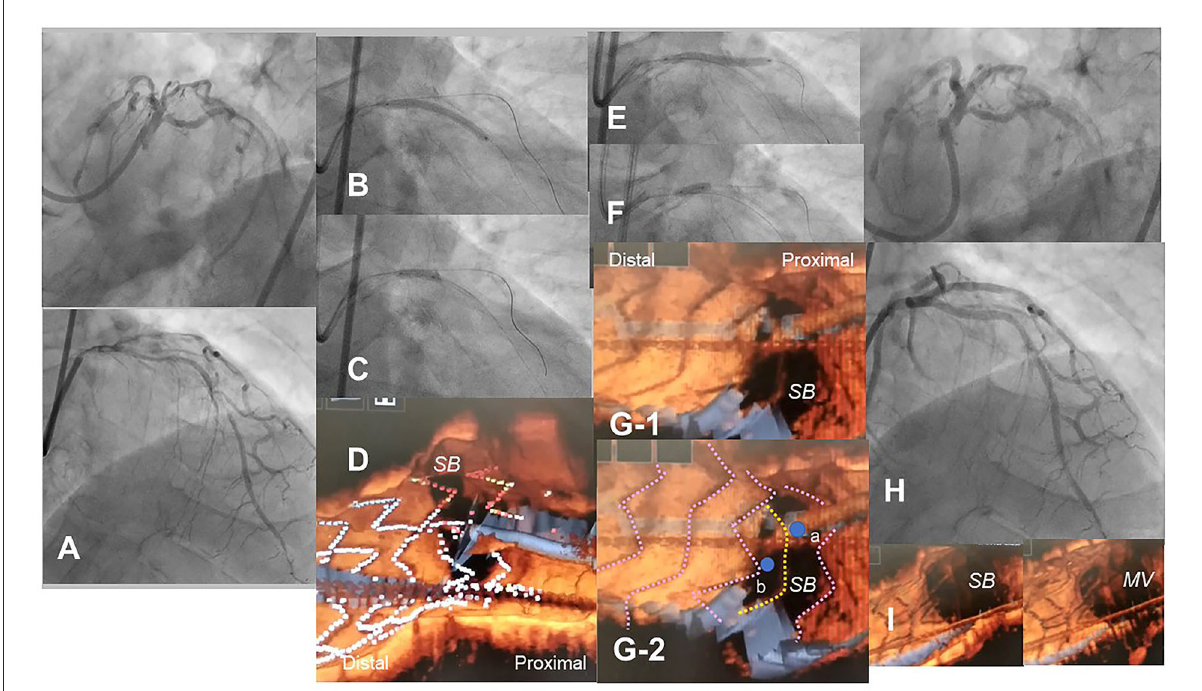
FIGURE8 Optical coherence tomography (OCT)-guided culotte stenting after rotational atherectomy in the calcified bifurcation lesion. A 72-year-old man with Medina 0-1-1 calcified lesion in left anterior descending artery (LAD)-diagonal bifurcation (A) was treated with culotte stenting after rotational atherectomy in both branches (Supplementary Movie 11). Rotational atherectomy using 1.75mm and 2.15mm burrs was performed in both LAD and diagonal branch, and OCT shows adequate ablation. A Ultimaster 3.0/33mm stent was implanted from proximal LAD to diagonal branch (B) followed by proximal optimization with a 3.75mm balloon (C) . 3D OCT showed the guidewire recrossed in the distal cell which occupied most largely in the diagonal branch ostium in the Link-free type that some proximal hoops of the far-distal cells with link-connection remained at the carina (D) . After the dilation of diagonal branch ostium, an Ultimaster 3.0/33mm stent was deployed in the LAD (E) followed by proximal optimization with a 3.75mm balloon (F) . The guidewire seemed to recross in the middle part of the jailing cells ( G-2